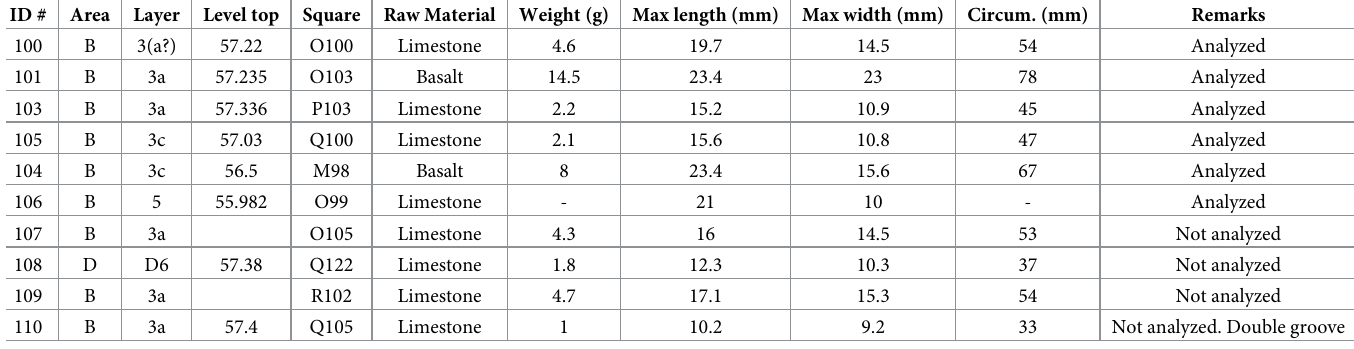
Table 3. Size measurements of the JRD grooved pebbles. The JRD grooved pebbles are reposited at the Prehistory Laboratory, Tel Hai College, Israel. The 3D grooved pebble models are available (wrl format) at